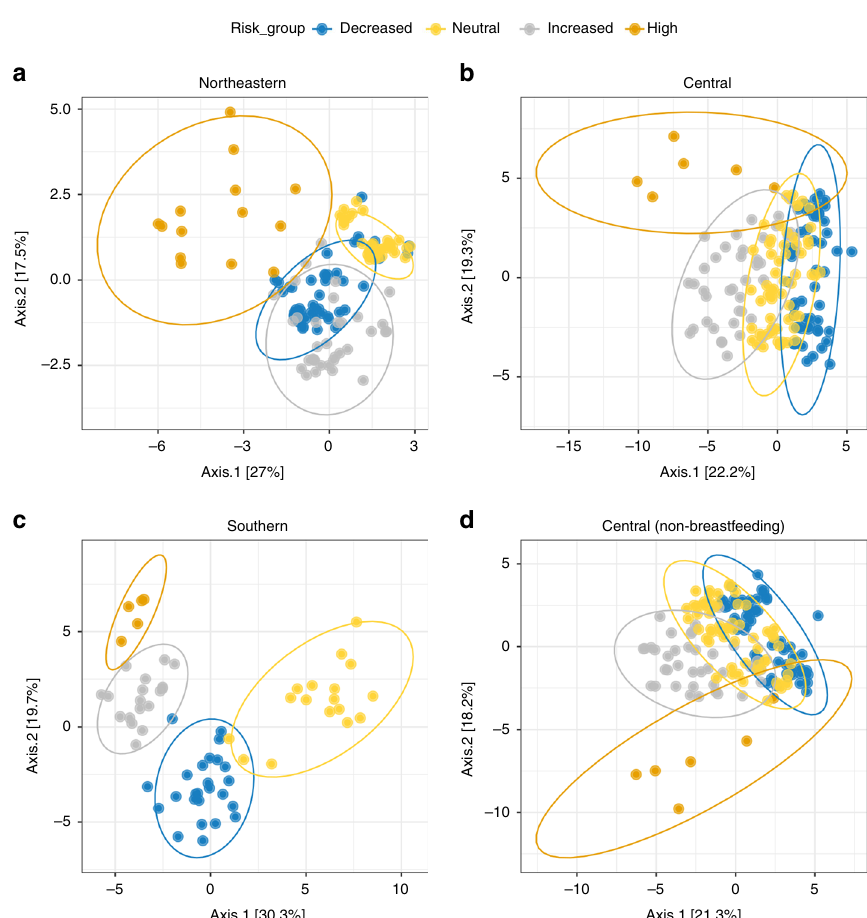
Fig. 6 Prevalent ASV clusters vary by HLA genotype across geography. a – d PCoA of inter-subject binomial distances for each of the three geographical clusters after applying 45% prevalence fi lter: a the Northeastern, b the Central, and c the Southern region. d Central region 45% prevalence after removal of samples from participants still breastfed at the time of sample collection. Ellipses are calculated based on a 95% con fi dence for each